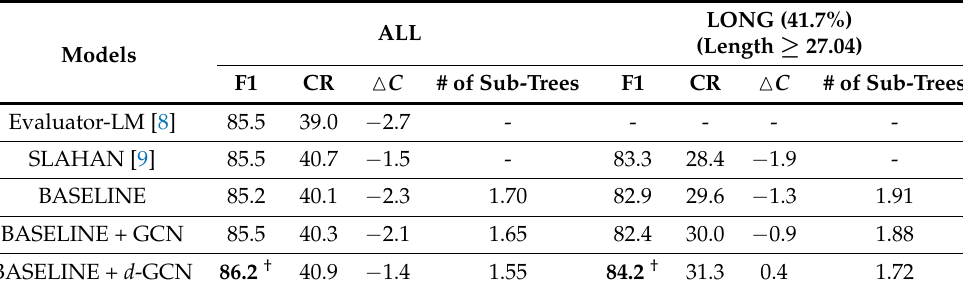
Table 3. Evaluation results for English sentence compression. † indicates that the difference of the F1 score from the baseline is statistically significant with 0.95 confidence. We used paired-bootstrap- resampling [13] with 1,000,000 random samples.